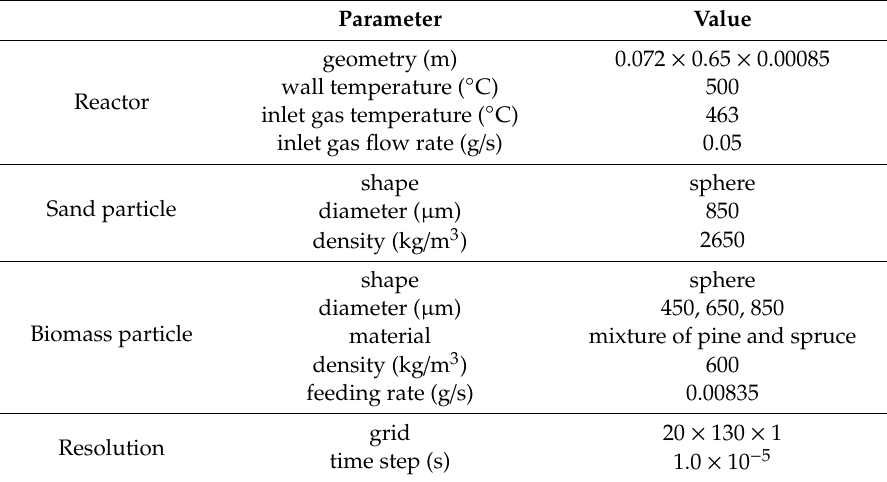
Table 3. Simulation setups of the fluidized-bed reactor.